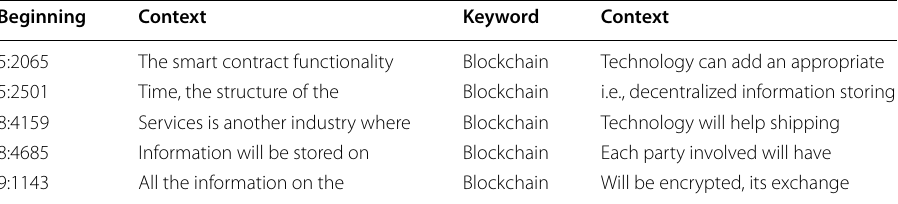
Table 2 Examples of the “blockchain” keyword in